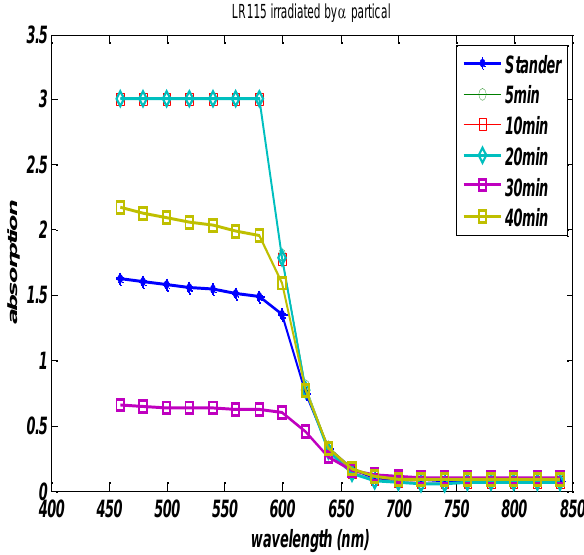
Fig. 1:The visible spectrum of the pristine and alpha-irradiated LR-115.